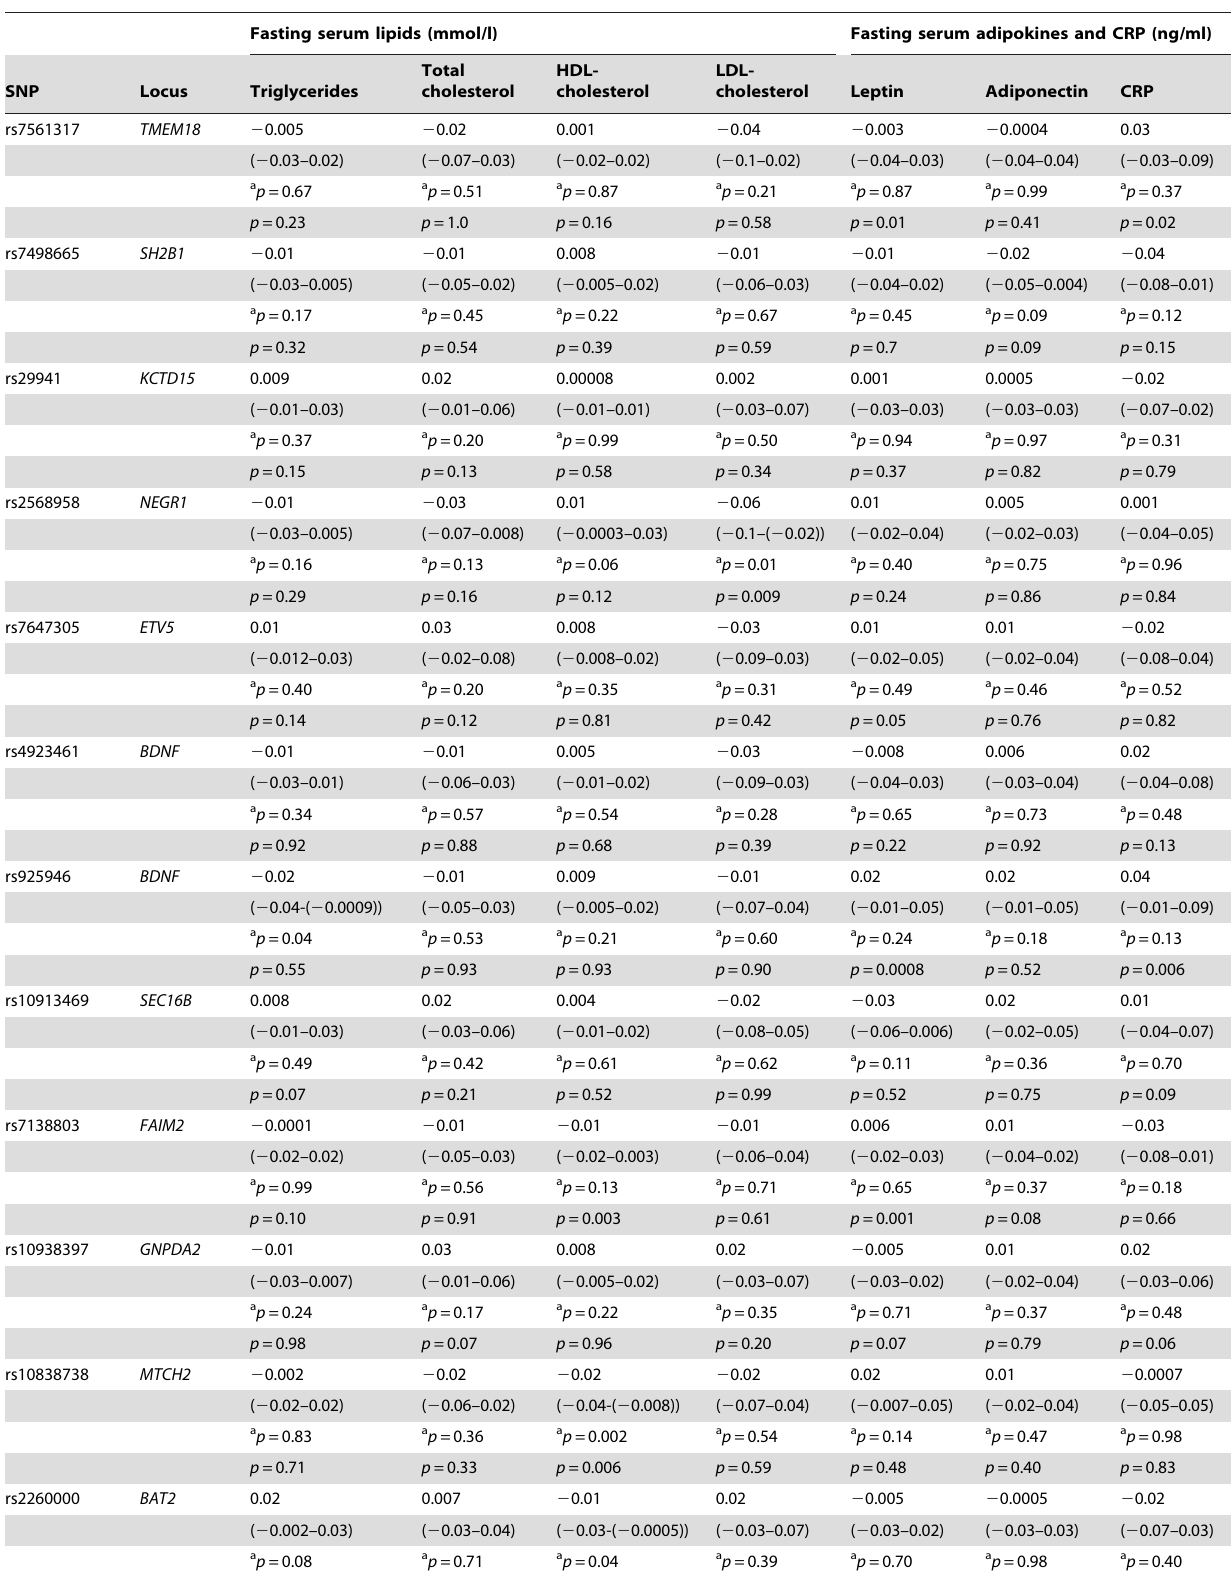
Table 3. Effects sizes of fasting serum lipids, adipokines and CRP, with and without adjustments for BMI in the population-based Inter99